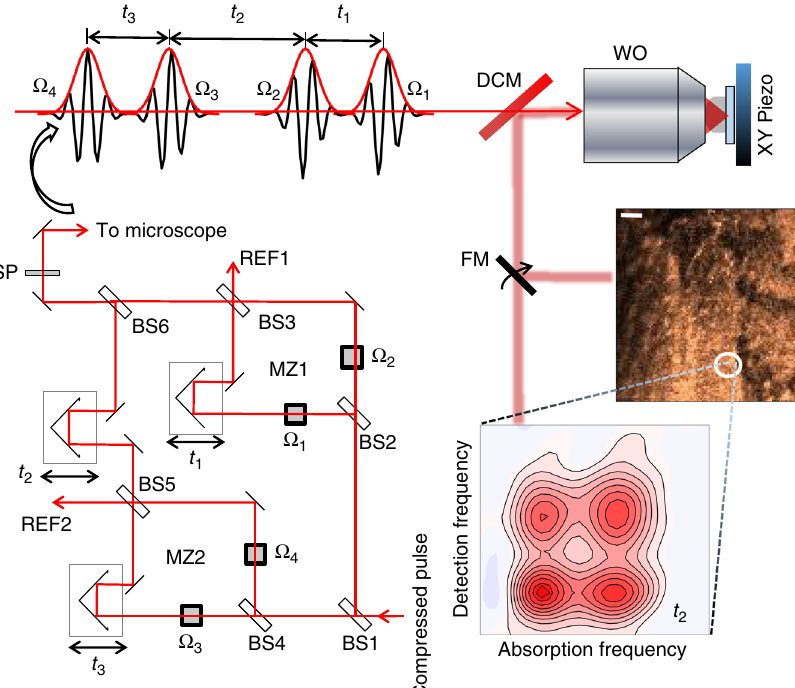
Fig. 1 Spatially resolved fl uorescence-detected 2DES spectrometer (SF-2DES). Further details of the spectrometer are provided in Supplementary Figure